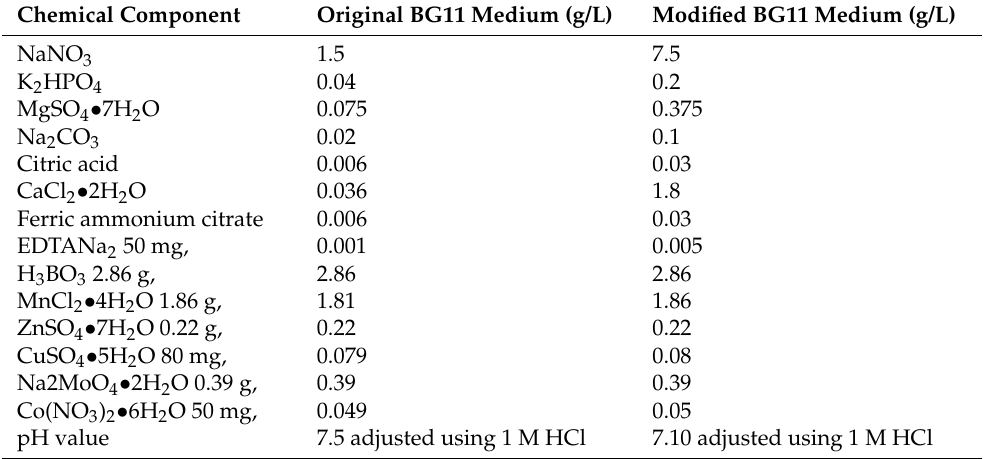
Table 1. The chemical components of the original and modified BG11 growth media used in this